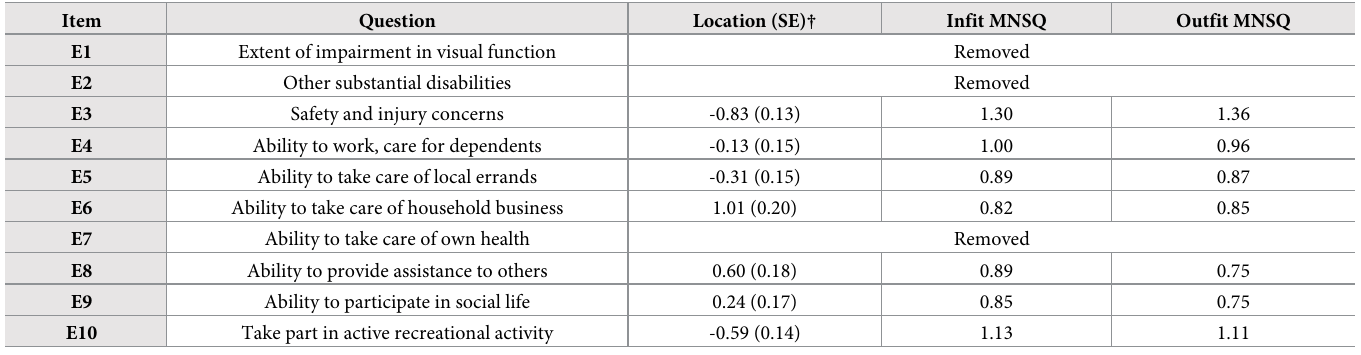
Table 4. Rasch analysis results of eCAPS